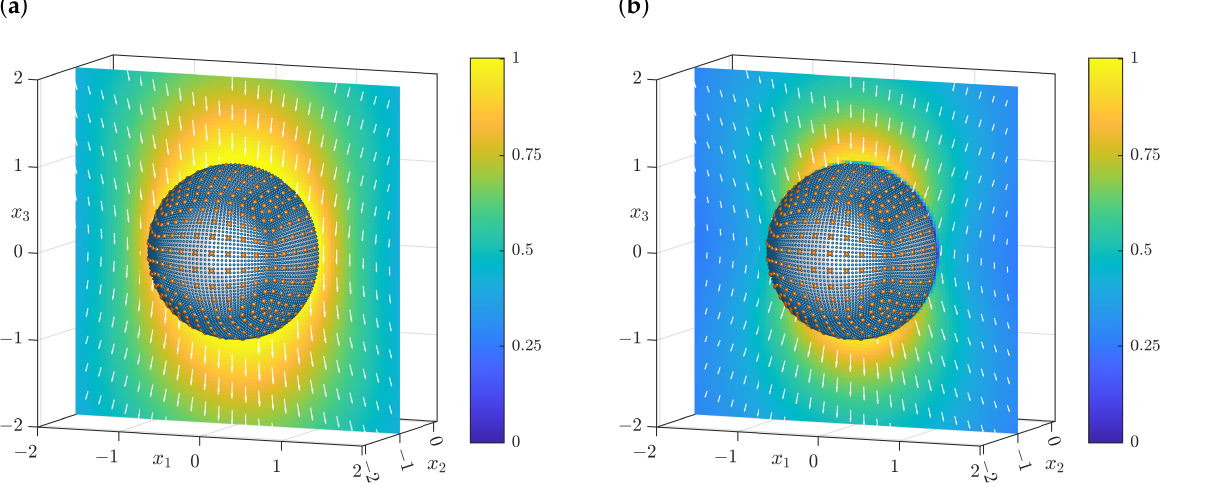
Figure 2. Collocation points (orange), quadrature points (blue), and flow field (background colour and white arrows) due to resistance problems around a unit sphere translating with velocity U = ( 0,0, − 1 ) calculated with the nearest neighbor discretisation: ( a ) no-slip boundary conditions, solved with single-layer formulation (problem 1N); ( b ) free-slip boundary conditions, solved with the fully regularised stokeslet boundary integral